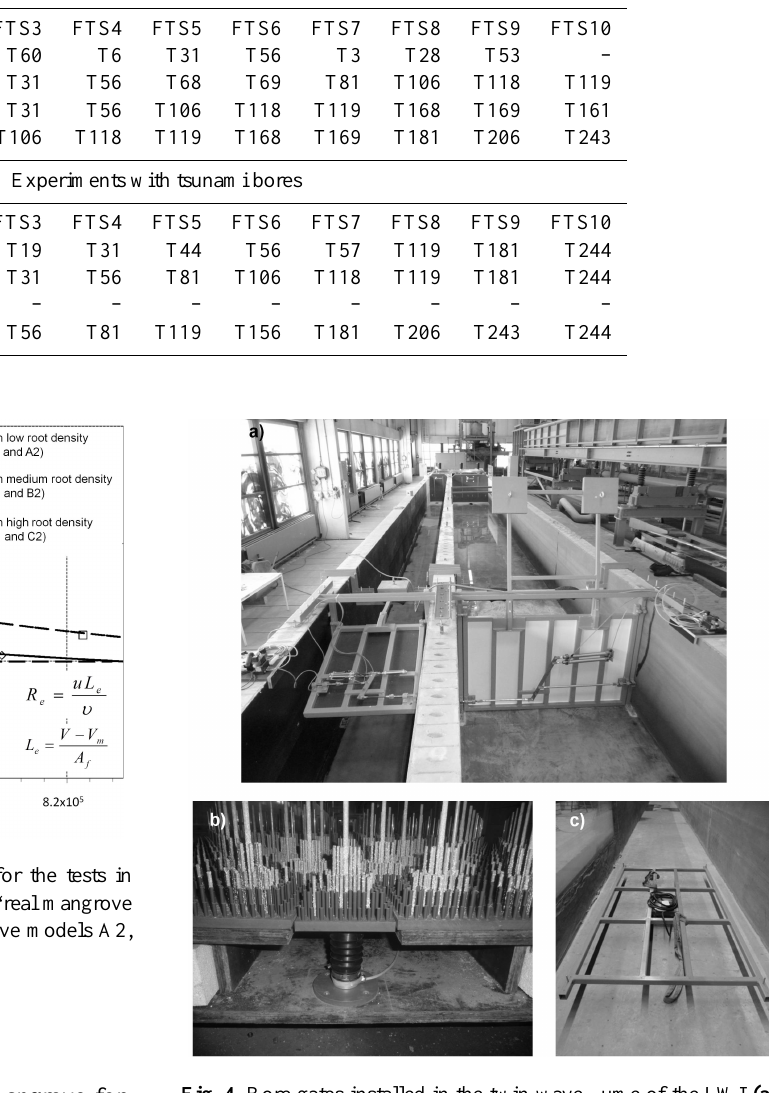
Fig. 4. Bore gates installed in the twin-wave flume of the LWI (a) , force transducer connected to a single mangrove tree model, mea- suring wave-induced forces (b) , force transducer measuring wave- induced forces exerted on entire forest model (c)